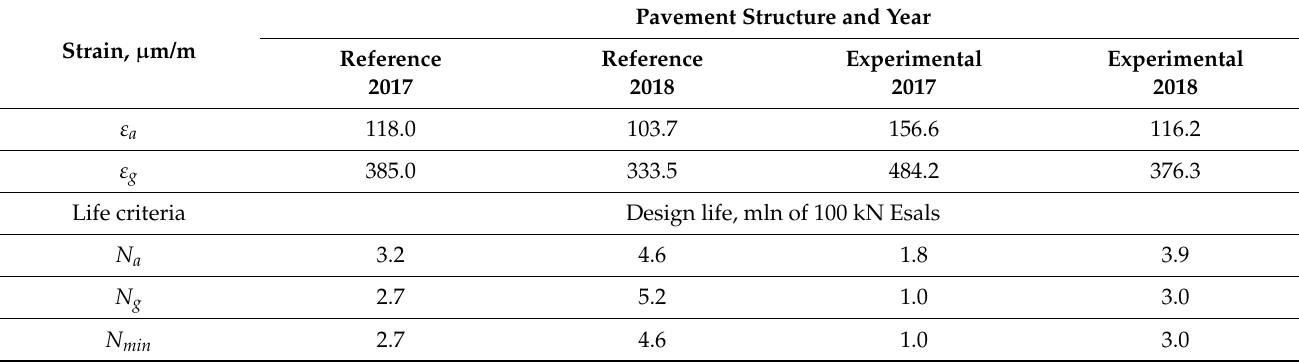
Table 2. Strains and calculated life criteria for reference and experimental